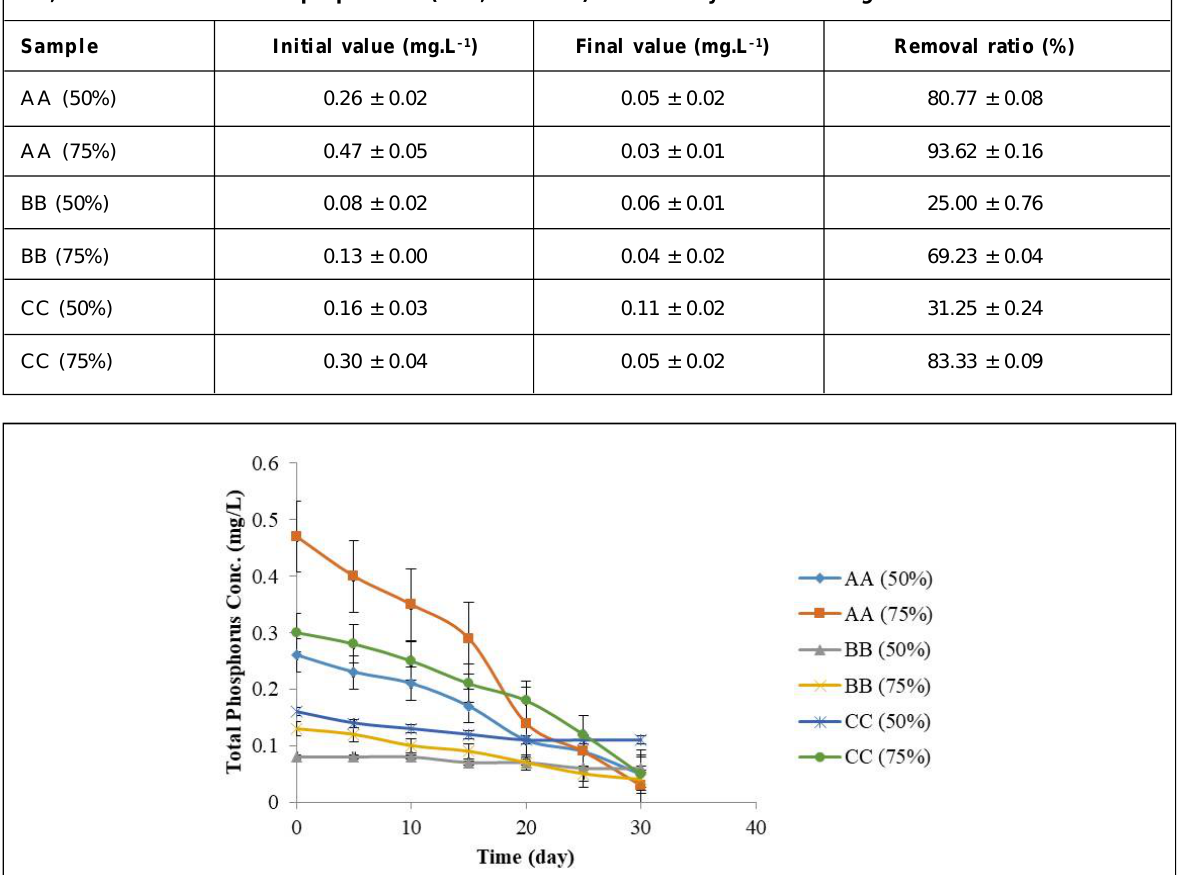
Table 3.2: Total phosphorus removal ratio in samples mixture of microalgae and industrial wastewater AA, BB, and CC with different proportions (50%, and 75%) removed by Chlorella vulgaris Sample